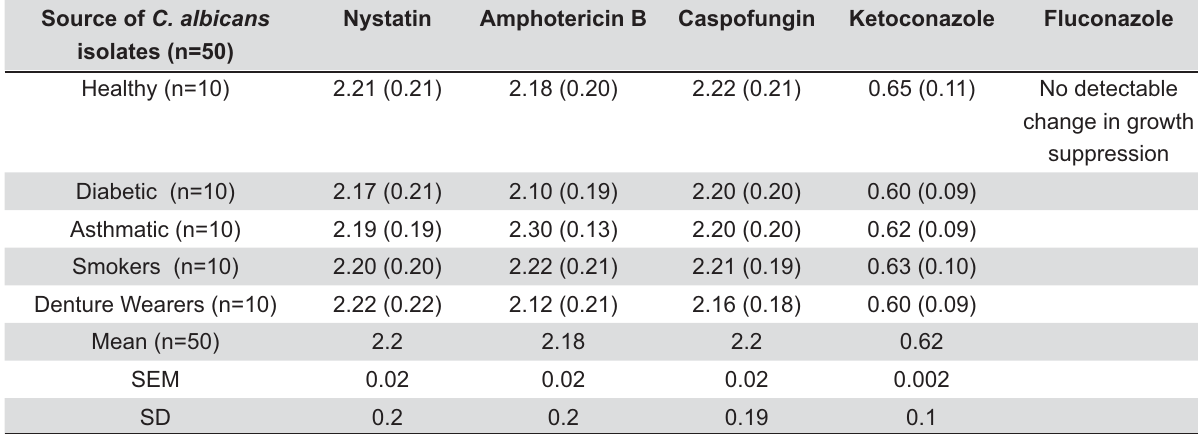
Table 1- The post-antifungal effect (PAFE) (in hours) of 50 oral C. albicans isolates following 1 hour exposure and subsequent (cid:2)(cid:3)(cid:4)(cid:5)(cid:6)(cid:7)(cid:8)(cid:9)(cid:5)(cid:10)(cid:9)(cid:11)(cid:6)(cid:3)(cid:9)(cid:12)(cid:13)(cid:10)(cid:10)(cid:3)(cid:2)(cid:3)(cid:14)(cid:15)(cid:9)(cid:7)(cid:14)(cid:15)(cid:13)(cid:10)(cid:16)(cid:14)(cid:17)(cid:7)(cid:8)(cid:9)(cid:12)(cid:2)(cid:16)(cid:17)(cid:18)(cid:19)(cid:9)(cid:20)(cid:7)(cid:21)(cid:22)(cid:9)(cid:6)(cid:7)(cid:8)(cid:16)(cid:3)(cid:9)(cid:13)(cid:14)(cid:12)(cid:13)(cid:21)(cid:7)(cid:15)(cid:3)(cid:18)(cid:9)(cid:15)(cid:22)(cid:3)(cid:9)(cid:4)(cid:3)(cid:7)(cid:14)(cid:9)(cid:23)(cid:24)(cid:25)(cid:26)(cid:9)(cid:5)(cid:10)(cid:9)(cid:27)(cid:28)(cid:9)(cid:5)(cid:2)(cid:7)(cid:8)(cid:9) C. albicans obtained either from healthy individuals, diabetic patients, asthmatic patients, smokers or denture wearers. Regarding PAFE, 0.25=15 minutes; 0.50=30 minutes; 0.75=45 minutes; 1.0=60 minutes. SD: Standard deviation. SEM: Standard error of